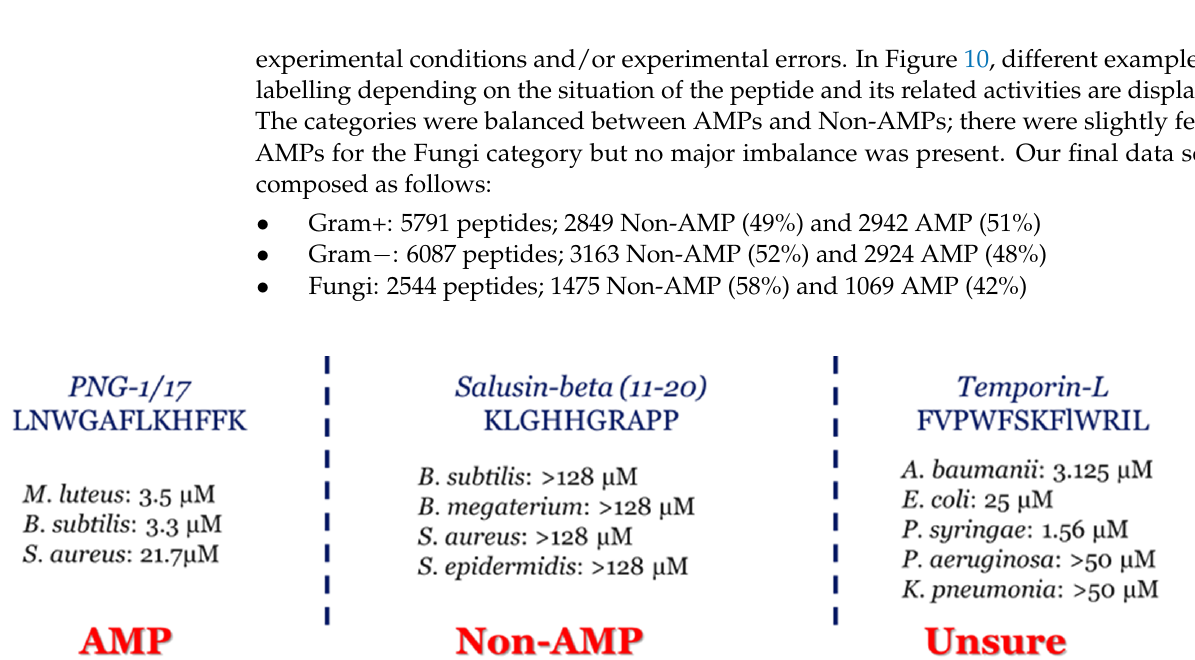
Figure 11. PCA projections of the training set (blue) and external test set (red) for Gram+ ( a ) and Gram − ( b ) categories.